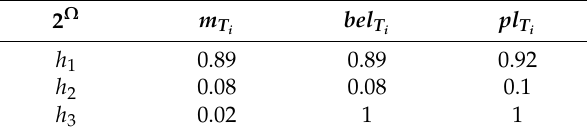
Table 3. BBA fusion for appliances X and